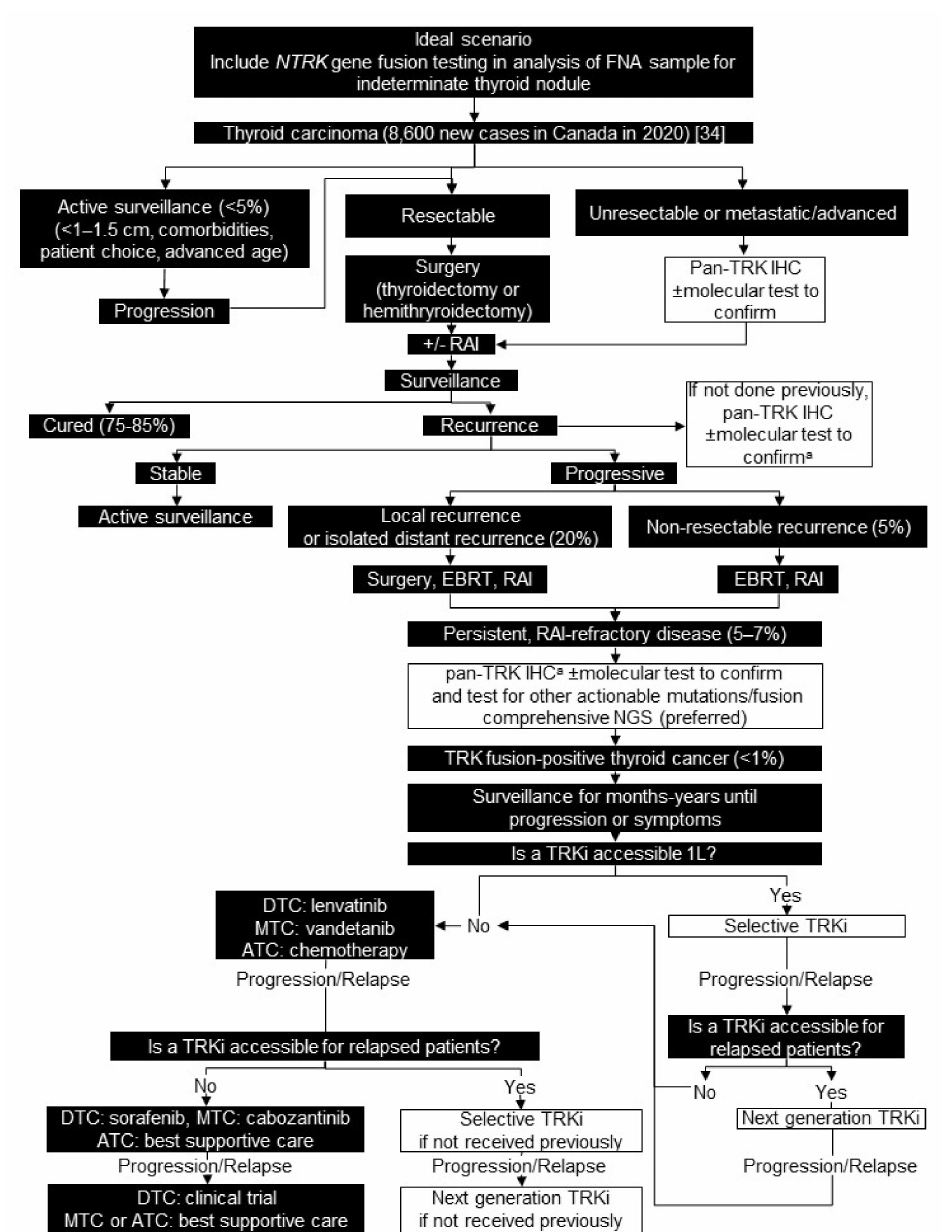
Figure 1. Biomarker testing and treatment for neurotrophic tyrosine receptor kinase ( NTRK ) gene fusions in thyroid carcinoma. White boxes with black outlines represent either NTRK gene fusion testing or treatment with a TRKi. Black boxes with white text indicate all other steps that do not include either NTRK gene fusion testing or treatment with a TRKi. a Consider obtaining fresh tissue to confirm diagnosis and provide more recent tissue for biomarker testing. ATC = anaplastic thyroid carcinoma; DTC = di ff erentiated thyroid carcinoma; EBRT = external beam radiation therapy; FNA = fine needle aspiration; IHC = immunohistochemistry; L = line; MTC = medullary thyroid carcinoma; NGS = next generation sequencing; RAI = radioactive iodine; TRK = tyrosine receptor kinase; TRKi = TRK inhibitor. Brenner et al. 2020